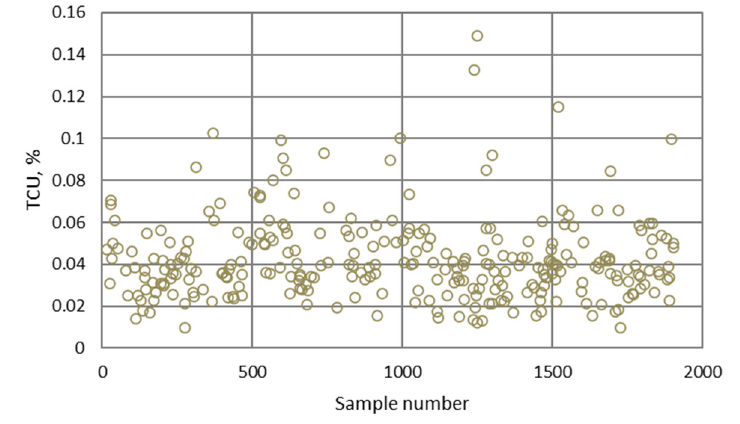
Figure A42. NN3 model—validation dataset.